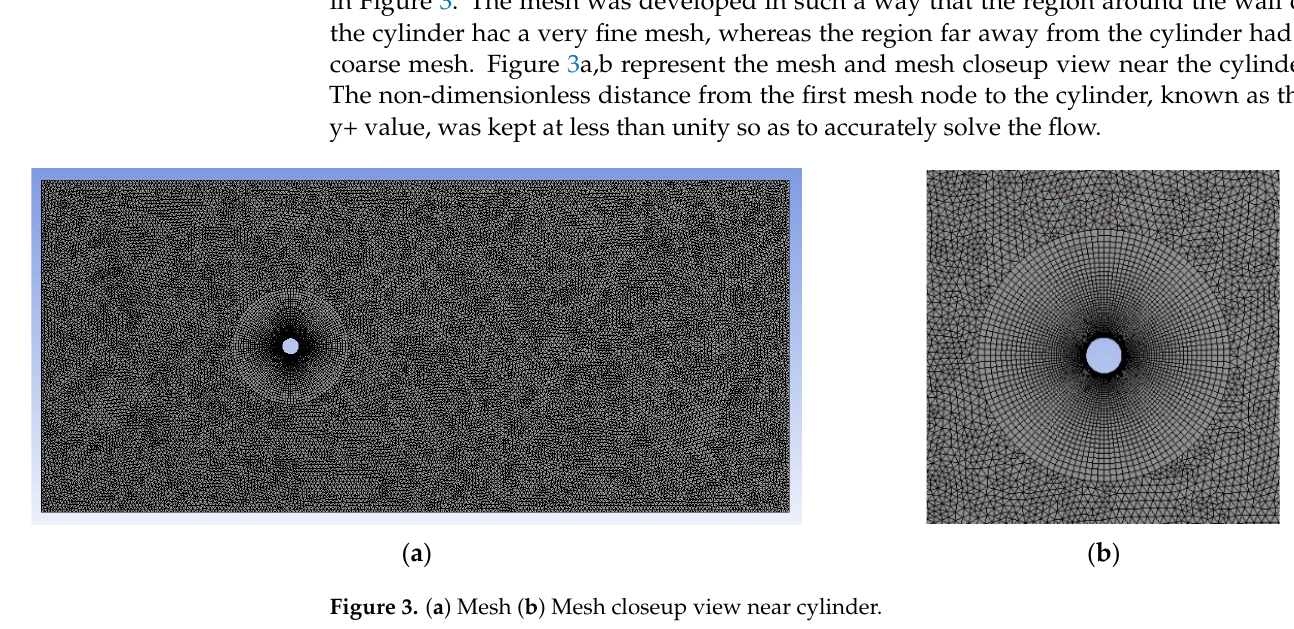
Figure 2. Computational domain.